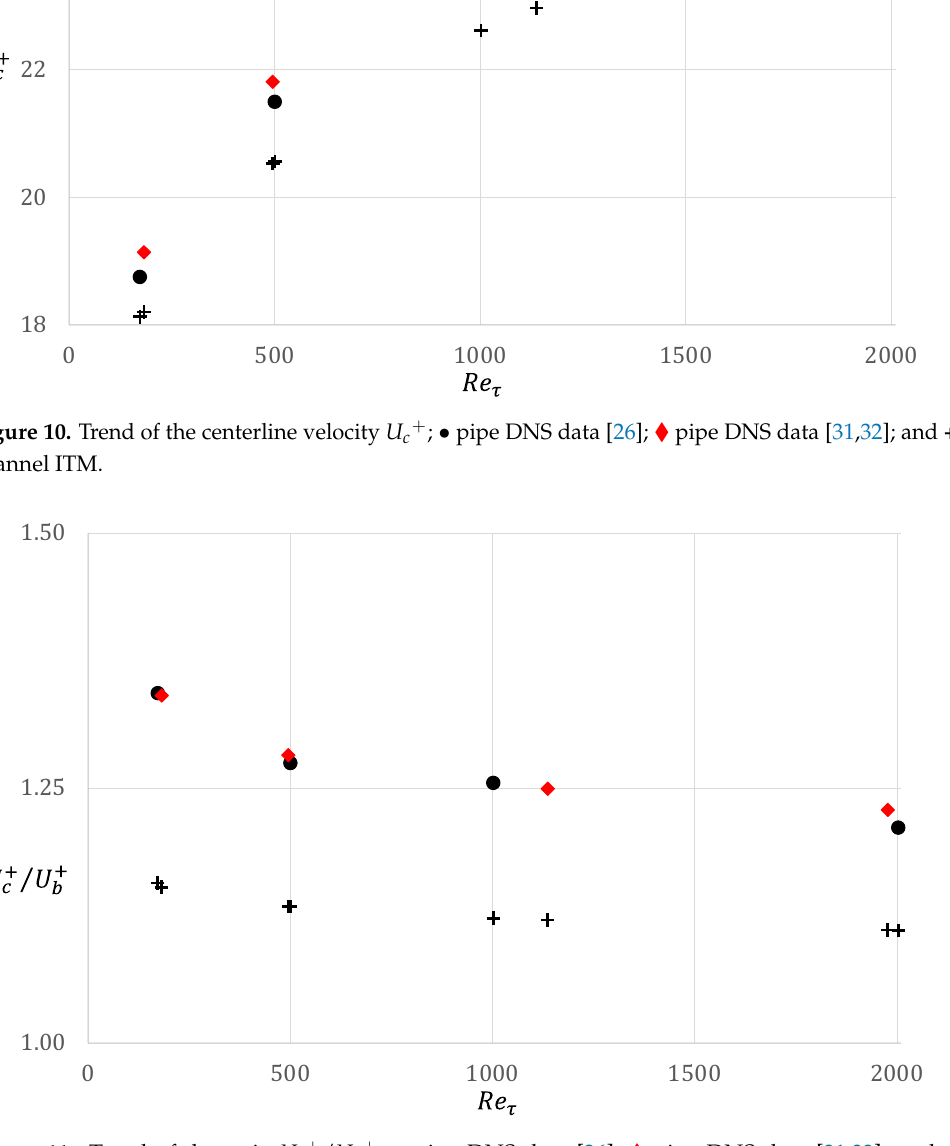
Figure 11. Trend of the ratio U c + / U b + ; • pipe DNS data [26]; (cid:7) pipe DNS data [31,32]; and + channel ITM.